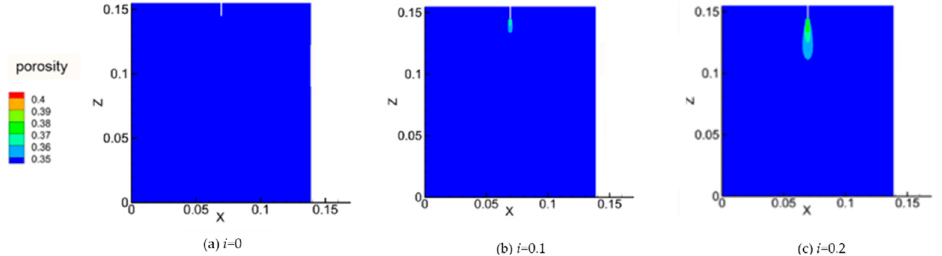
Figure 12. Porosity distribution for Run A in Skempton and Brogan [9] when i < i c = 0.28.